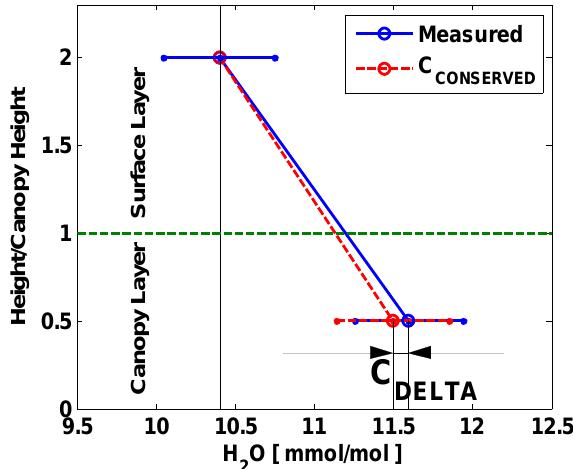
Figure 9. The estimated concentration, C CONSERVED (red) using standard flux–gradient similarities of H 2 O during midday (12:00–14:00) is shown. Blue represents the measured vertical gradient. Open circles and whiskers represent the mean and the variability of H 2 O. The difference between blue and red in the within-canopy level is shown by the black arrow and indicates C DELTA and is negligibly small as expected for a conserved species.